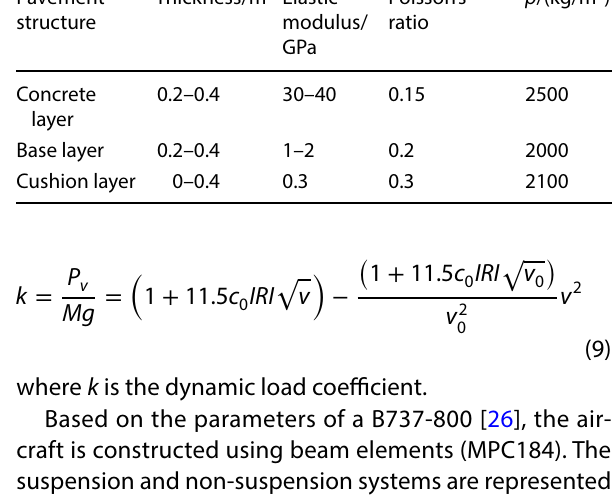
Table 2 Pavement structure parameters Pavement